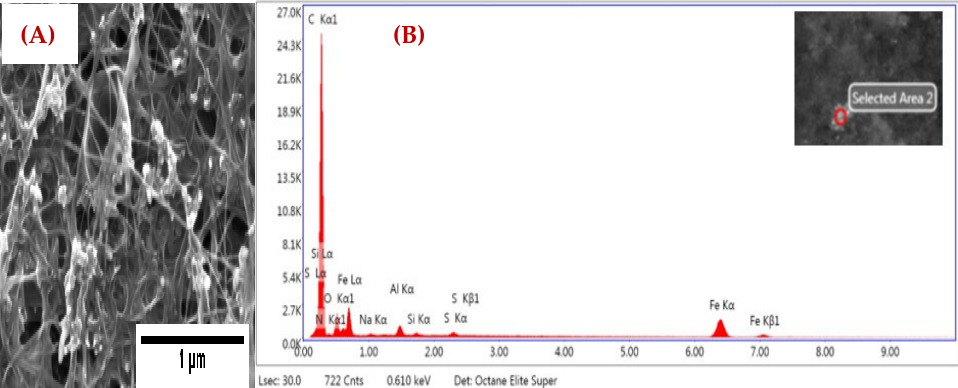
Figure 3. CNT on a thick tissue filtering layer ( A ) SEM image of captured PM at 1 μm, and ( B ) EDX spectrum of captured PM.